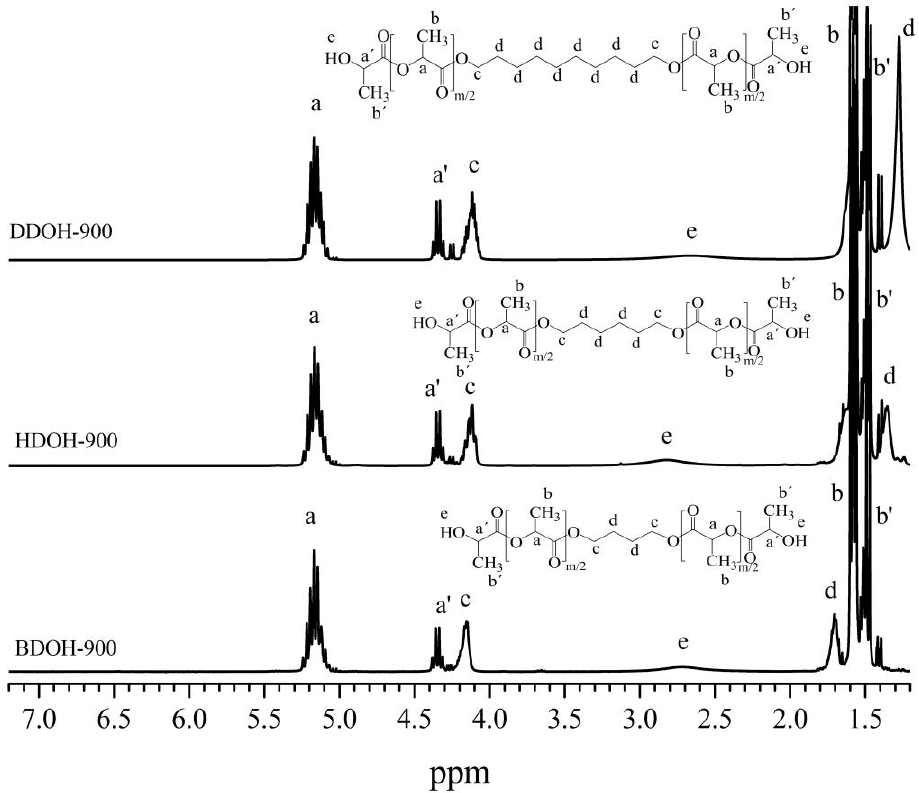
Figure 3. 1 H-NMR spectra of BDOH-900, HDOH-900, and DDOH-900.